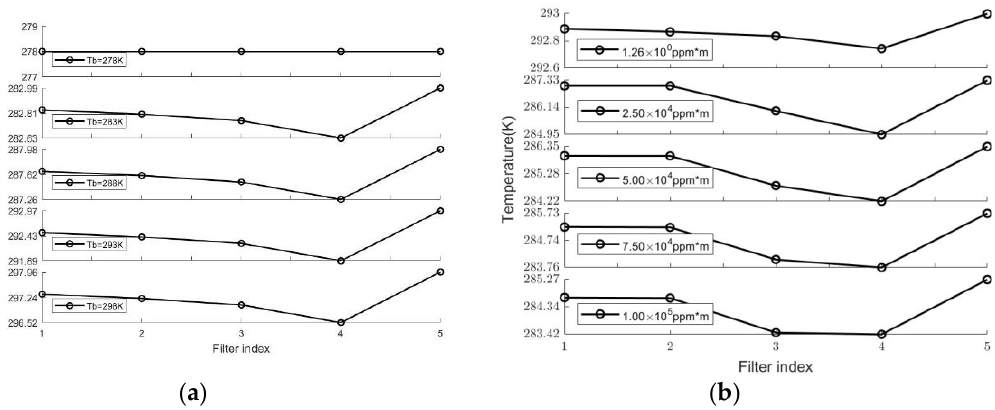
Figure 6. ( a ) Simulated SF6 spectra with different background temperature, shown as Tb, at cloud temperature 278 K, CL 2e 4 ppm*m. ( b ) Simulated SF6 spectra with different concentration at background temperature 293 K, air temperature 278 K.